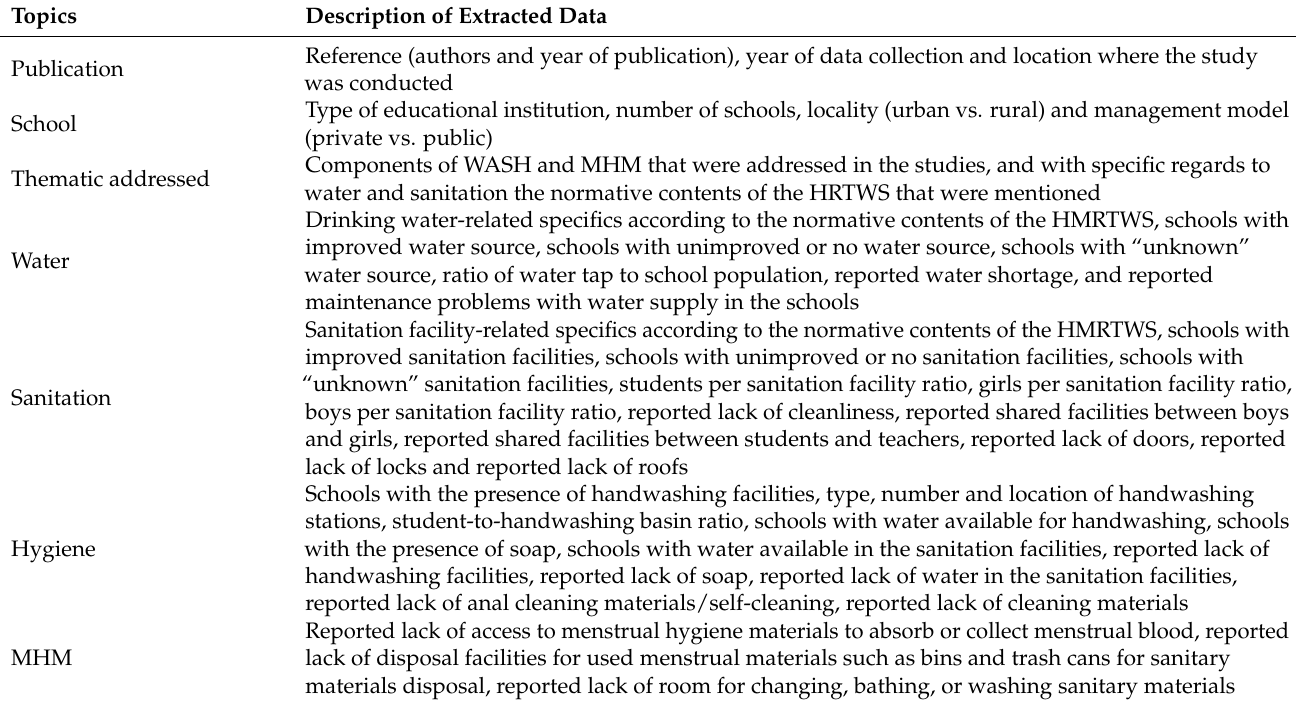
Table 2. Description of extracted